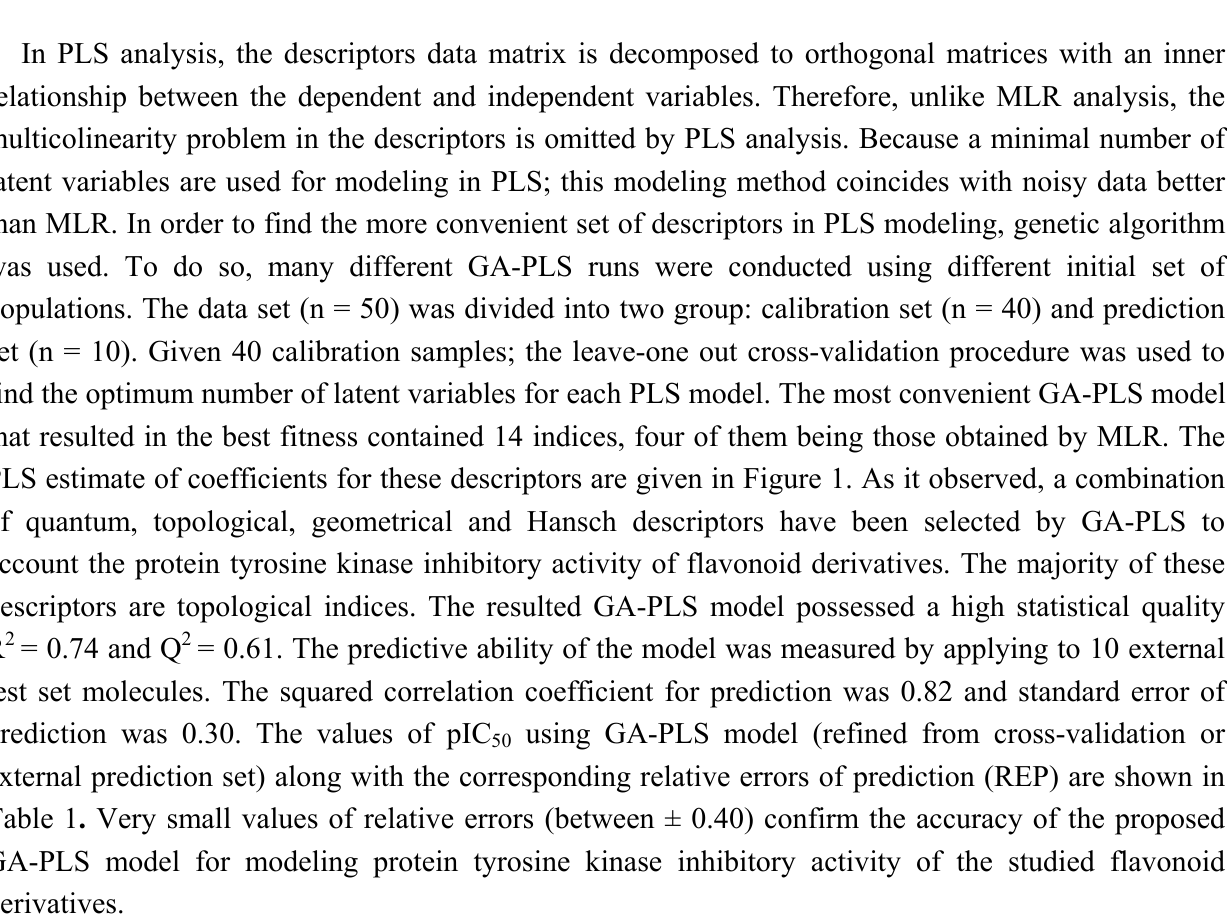
Figure 1. PLS regression coefficients for the variables used in GA-PLS model.